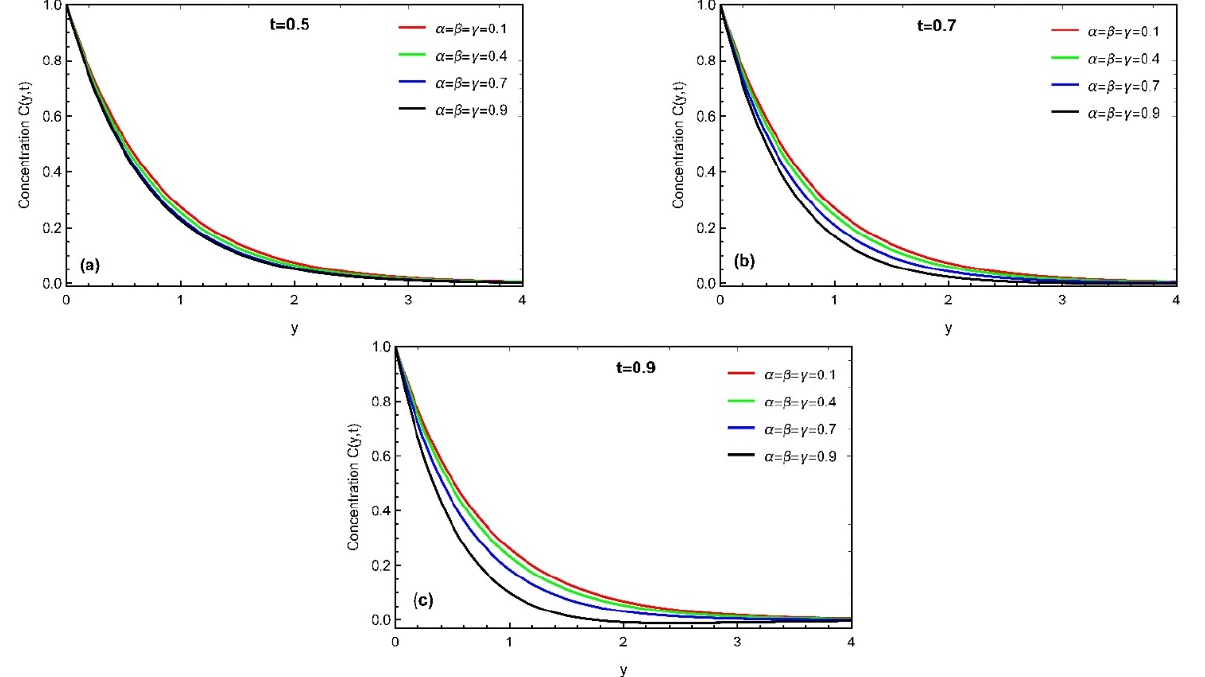
Figure 3. Variation in temperature due to effective Prandtl number at ( a ) 𝑡 = 0.5 ( b ) 𝑡 = 0.7 ( c ) 𝑡 = 0.9 .